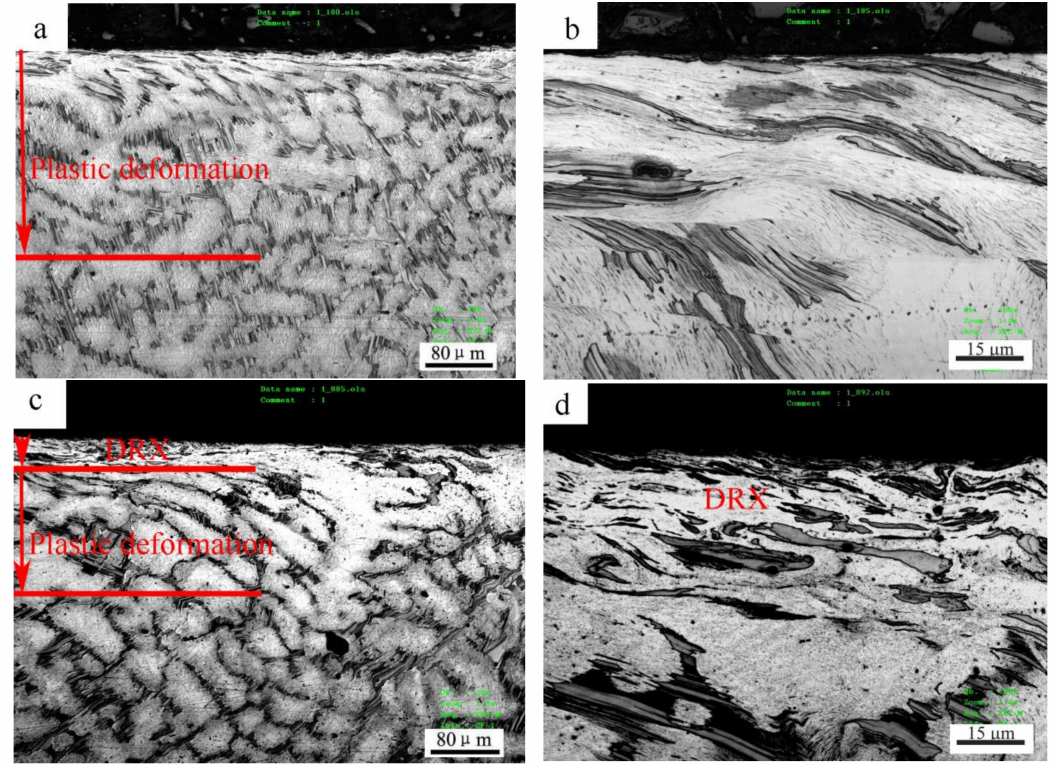
Figure 9. Cross-sectional optical microstructures of Mg97Zn1Y2 alloy after sliding at 3.0 m/s and different loads: ( a ) 40 N, ( b ) 40 N, showing deformation kinks of Mg 12 ZnY phase strips, ( c ) 100 N, ( d ) 100 N, showing fine DRX microstructure in surface